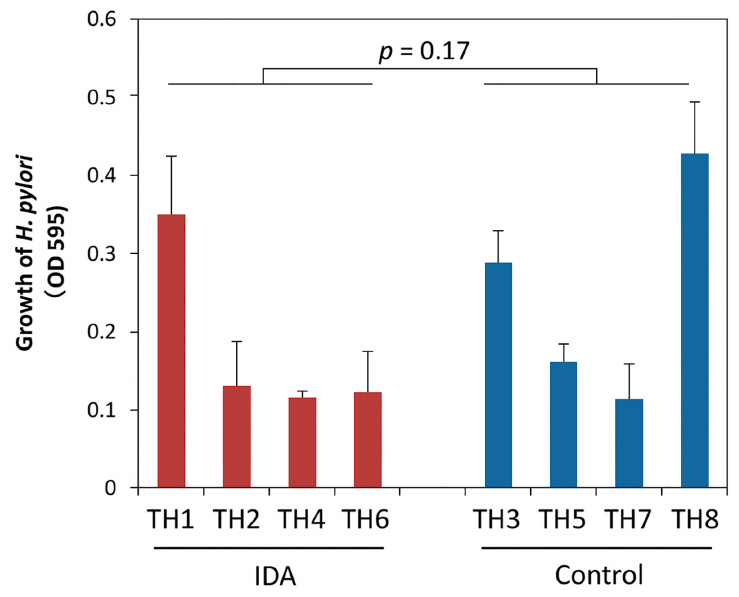
Fig 1. Growth of H . pylori strains isolated from IDA or control patients. Each strain was inoculated into Brucellabroth containing 5% horse serum at an initial OD 595 0.05. The growth of H . pylori was measured (OD 595 ) by microplate photometer after 24-hourincubation. The Mean ± SD24-hourgrowth value was measuredbasedon three independentdeterminations for each strain. Bacterial growth was not significantly different between the IDA and control strains ( p = 0.17; Wilcoxon rank sum